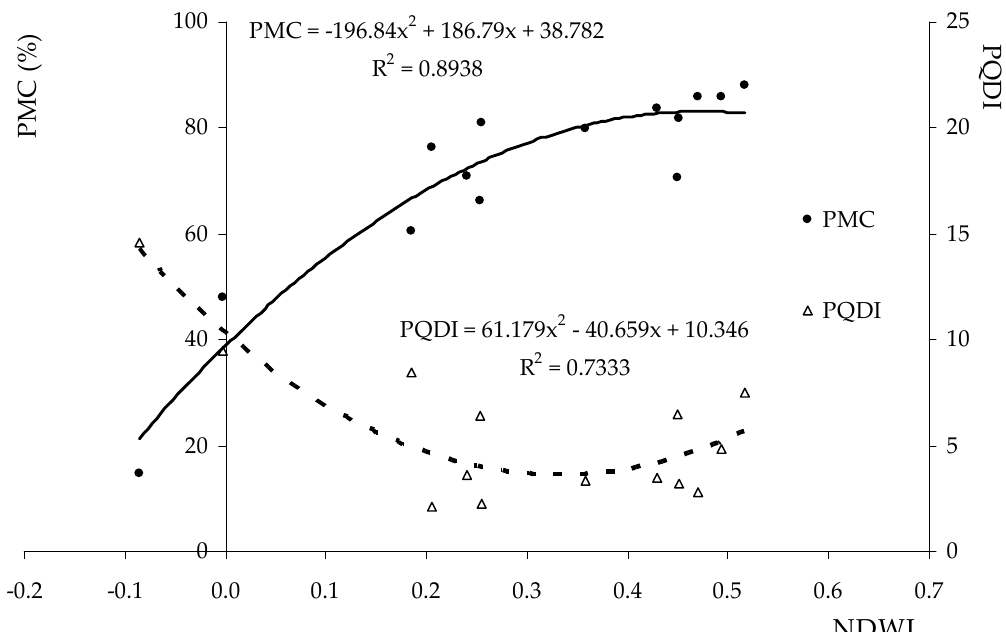
Figure 11. Relationship between normalized difference water index (NDWI), pasture moisture content (PMC) and pasture quality degradation index (PQDI) over sampling times (springs 2016–2018). Data are average values of the 12 sampling points.